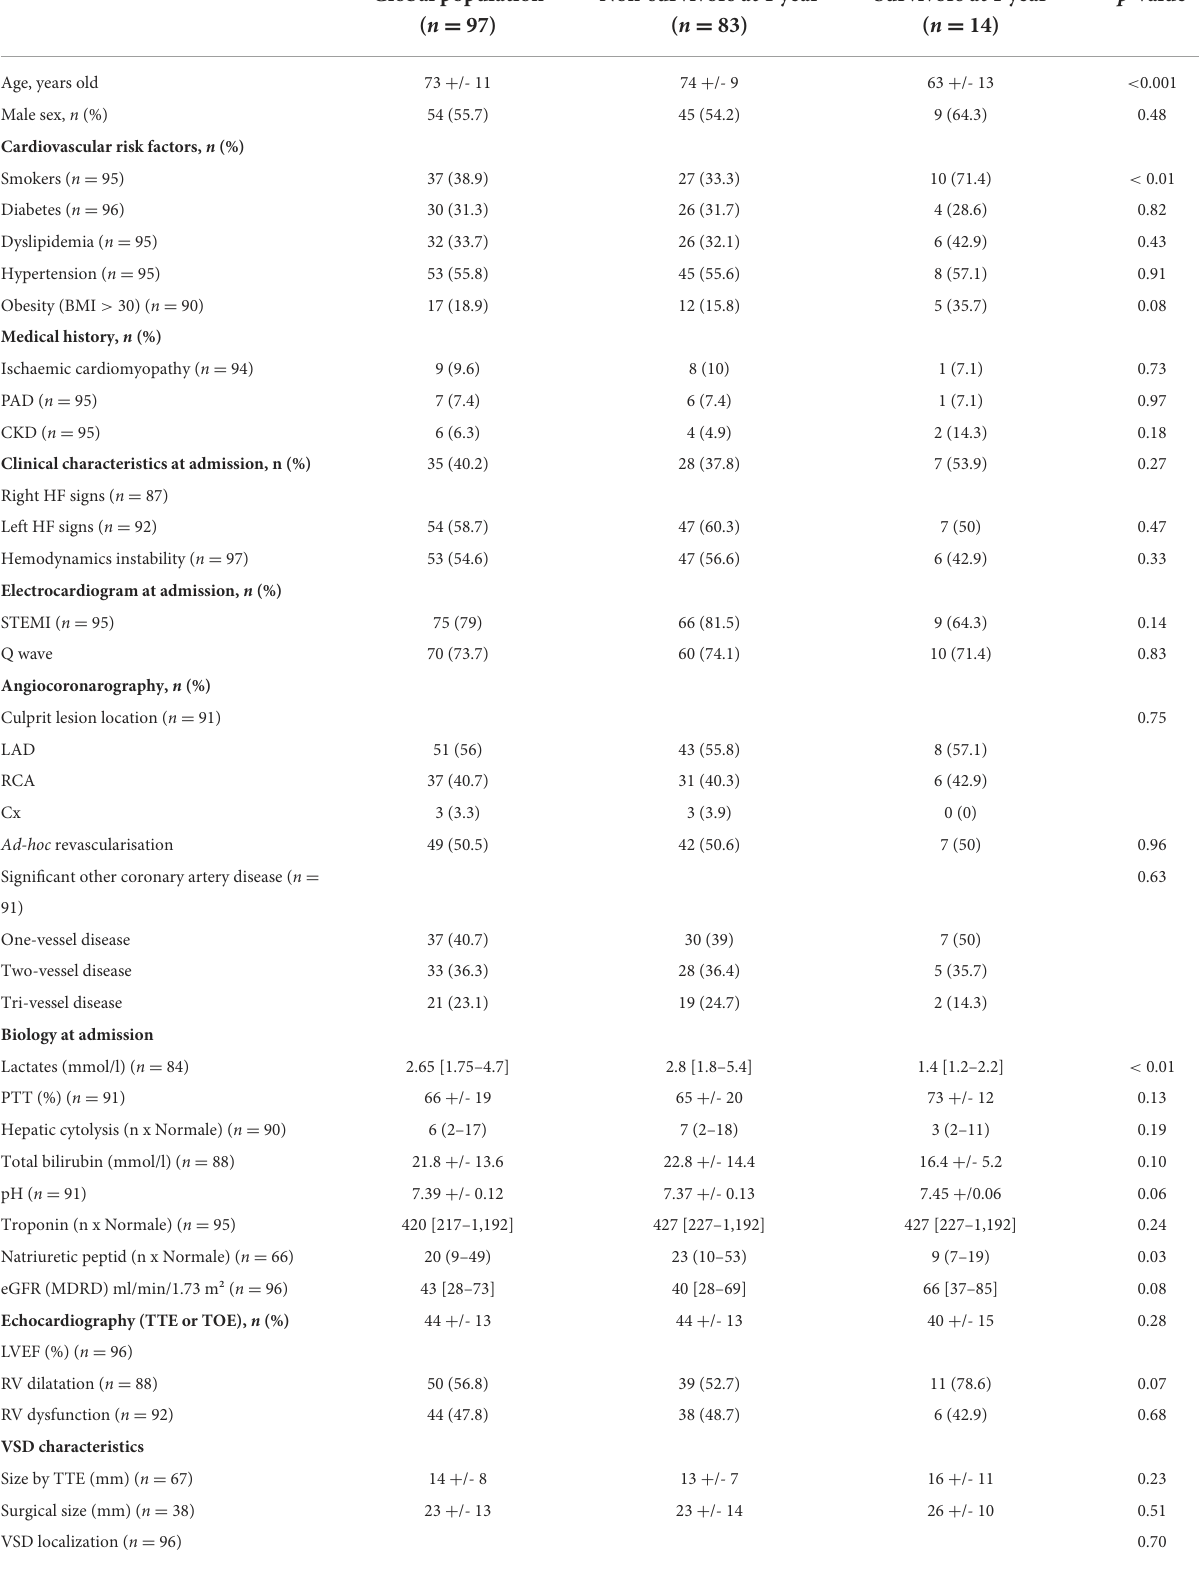
TABLE 1 Description of the population at admission, management, and outcomes according to their 1-year mortality. Global